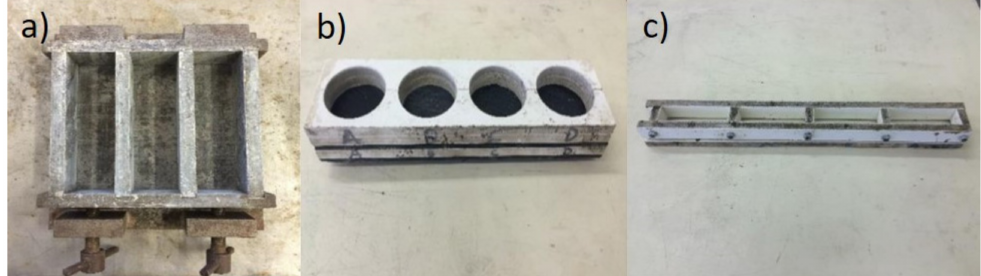
Figure 9. Moulds used in production of specimens: ( a ) standard specimens (40 × 40 × 160 mm 3 ); ( b ) thermal conductivity specimens (60 mm diameter and 20 mm thickness); ( c ) small-size specimens (20 × 20 × 80 × mm 3